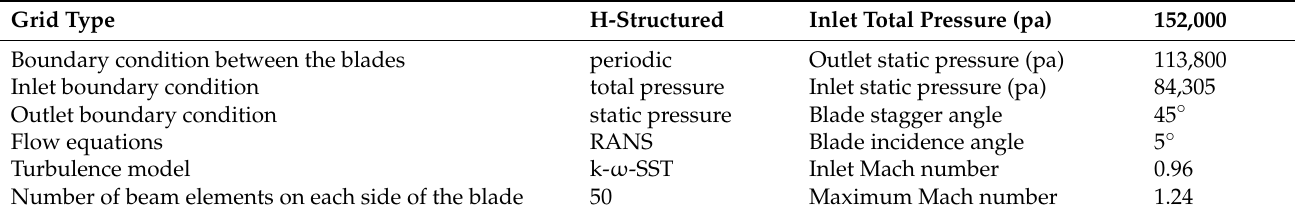
Table 3. Detailed information of inverse design in transonic flow by the modified